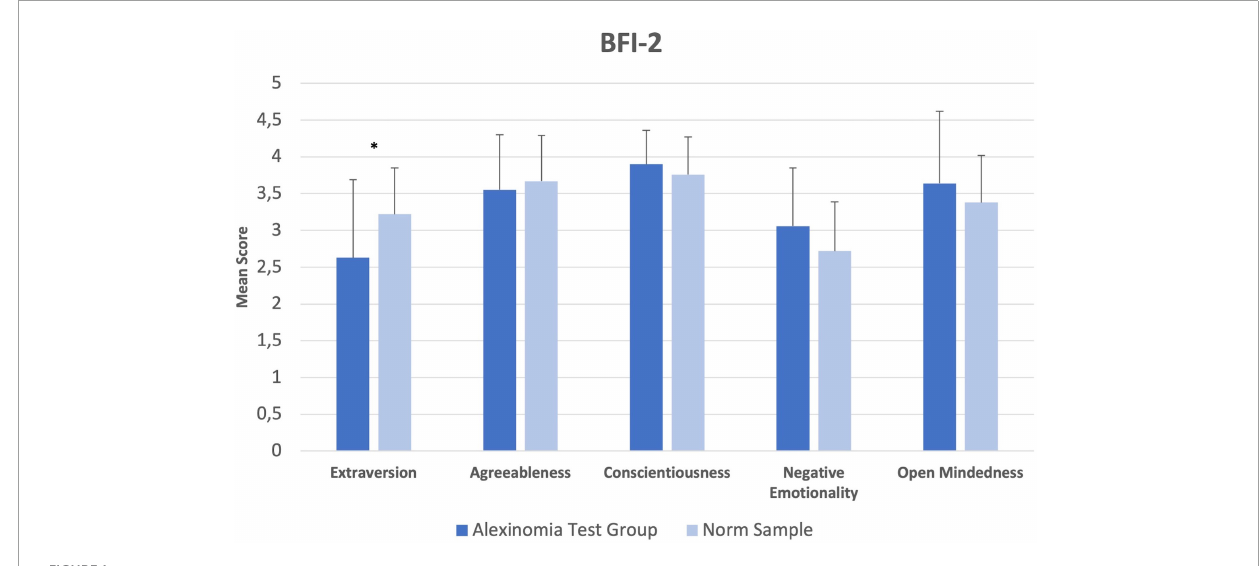
FIGURE1 BFI-2. Comparisons of group means in the BFI-2. Error bars indicate 1 SD. ∗ p <